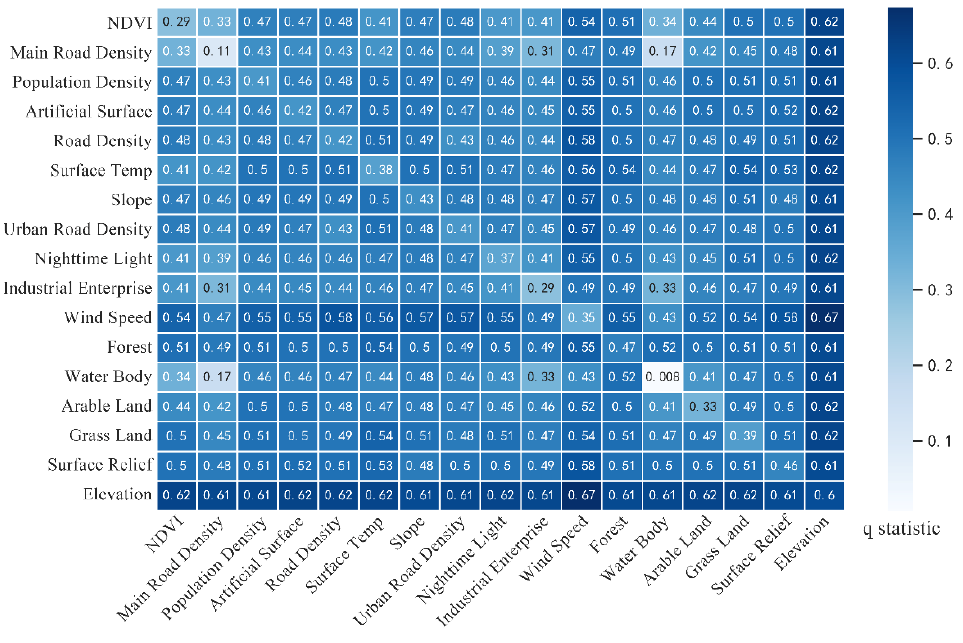
Figure 7. Results of interaction detector.